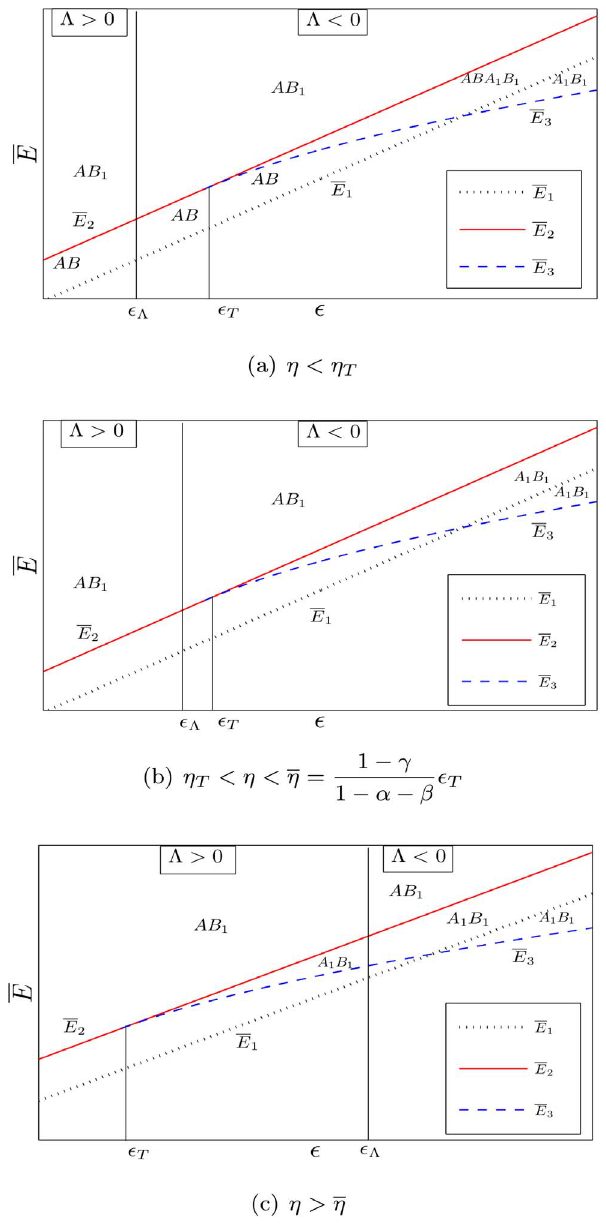
Fig. 1. Threshold values in the plane ( EE , E ) and existing stationary